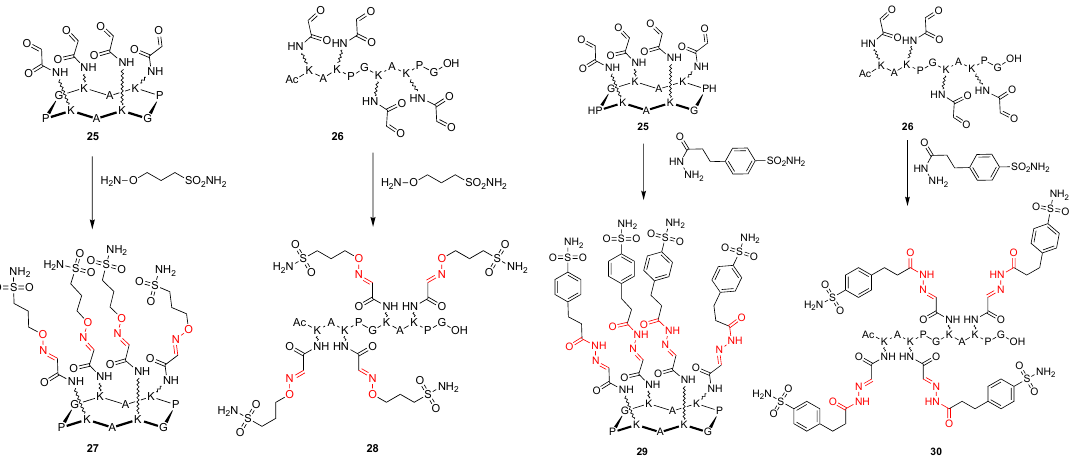
Figure 6. Multivalent CA inhibitors from functionalized peptide scaffolds with oxime or hydrazide ligation (in red). [30]